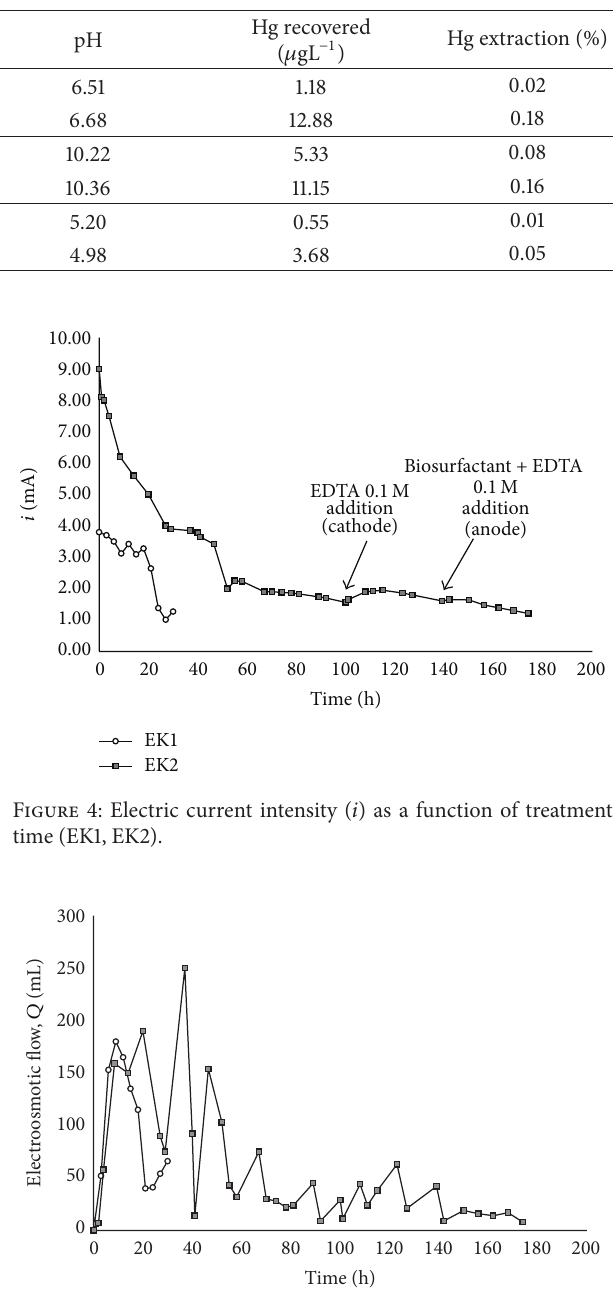
Table 5: pH and Hg extraction for all the treatments.